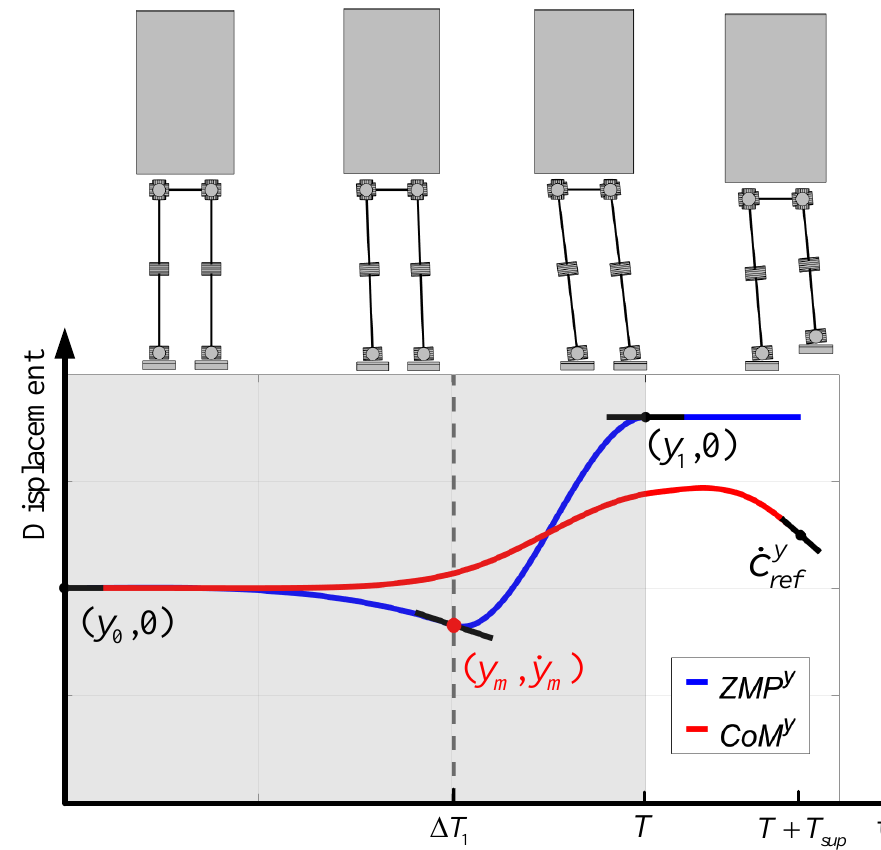
Figure 3. Segmented ZMP trajectory optimization during State Switching 1 (gray background). The short black lines are the tangent lines of two curves at the specified points. The robot switched from bipedal support to left-leg